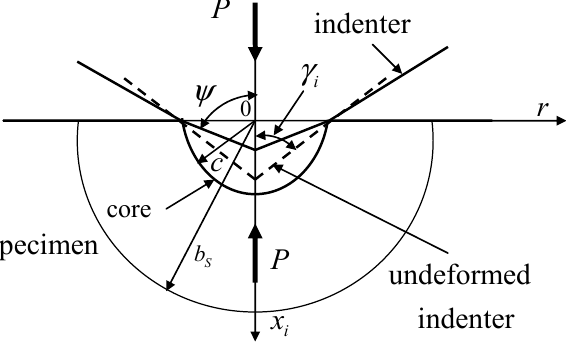
Figure 1. Scheme of interaction of an indenter and a specimen under a load Р in a spherical 2 ) coordinate system 0r θϕ , HM = P/( π c 2 ) . system 0r θψ , HM = P / ( π c